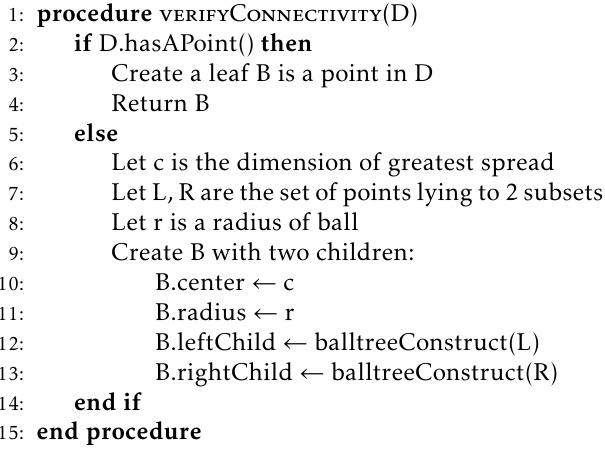
Algorithm 1 Verify the network connectivity of a